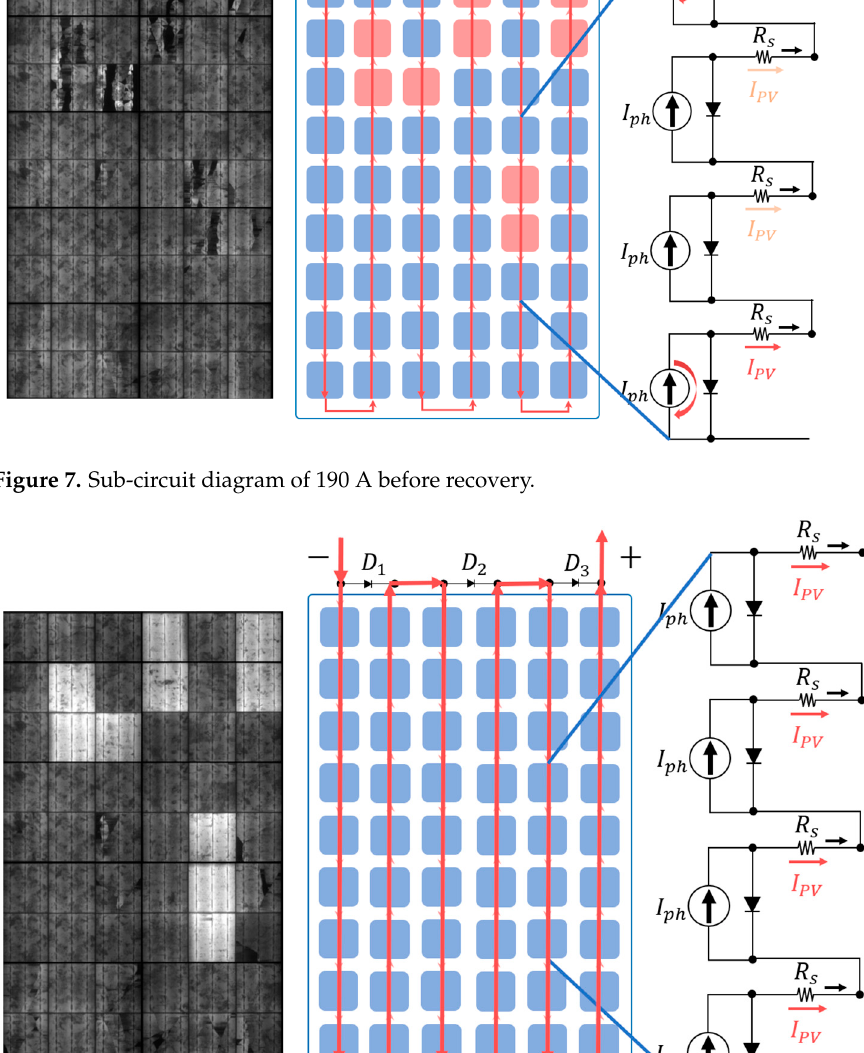
Figure 8. Sub-circuit diagram of module 190 A after recovery.